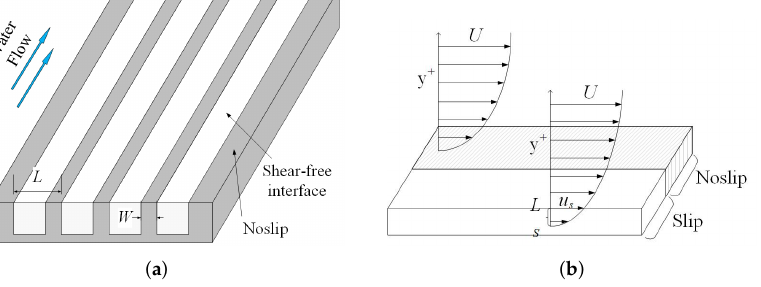
Figure 1. Schematic of streamwise strip on superhydrophobic surface. ( a ) Alternating free-slip and no-slip boundary condition. ( b ) Diagram of slip velocity.